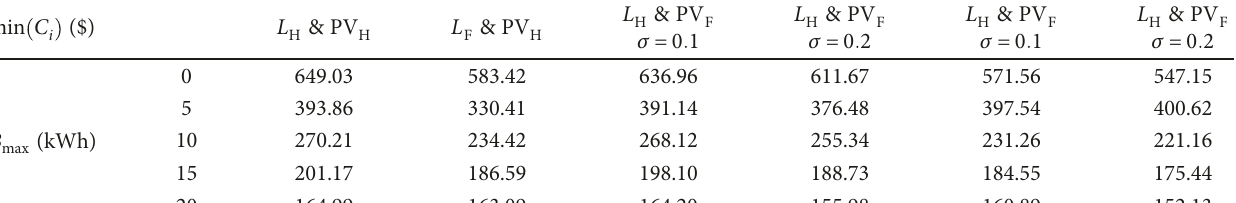
Table 3: Results of annual electricity expenses under min C